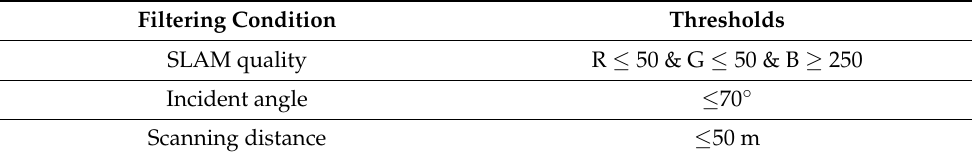
Table 11. Conditions and thresholds of point cloud filtering for a cadastral detail